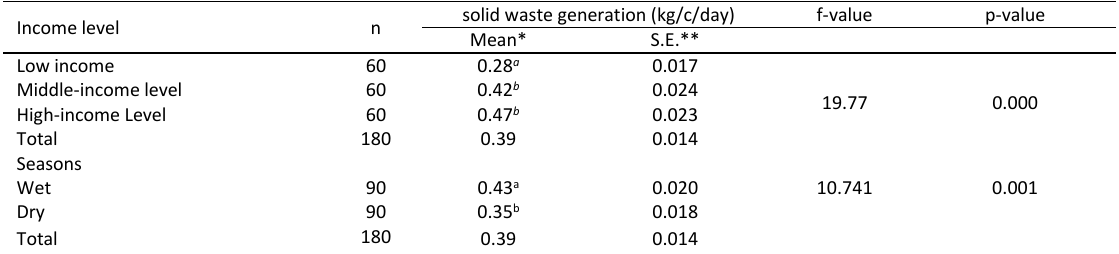
Table 2: Analysis of variance of solid waste generation under the three income levels and seasons